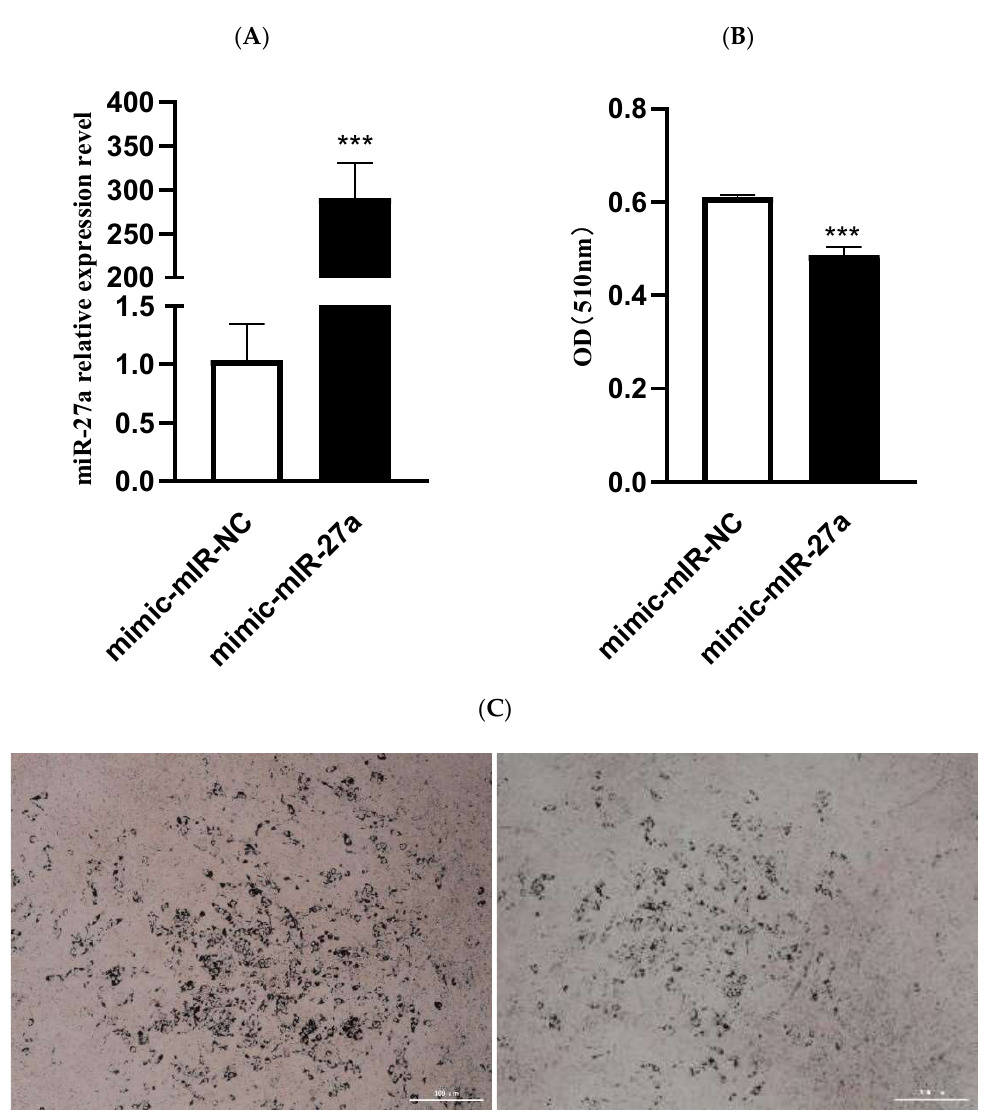
Figure 2. Effect of the miR-27a mimic on ovine preadipocytes. ( A ) miR-27a expression following miR-27a mimic treatment; ( B ) cellular lipid content as determined by spectrophotometry; ( C ) change in lipid droplet accumulation in ovine preadipocytes following miR-27a mimic treatment. *** p < 0.001.